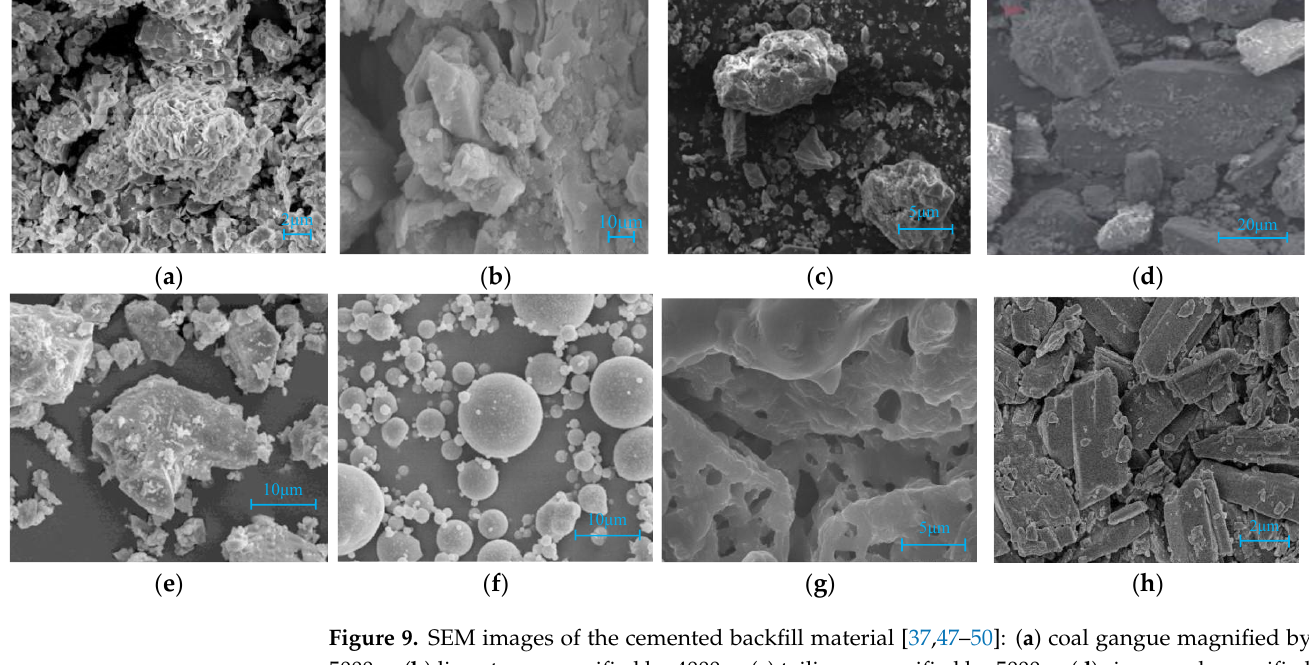
Figure 8. Percentages of the different participants in cemented backfill material. Coal gangue: The most common coarse aggregate in the cement filling material is coal gangue. It is the incombustible rock mass produced during underground coal mining processes, such as the coal cutting procedure at the coal mining face and the blasting procedure at the roadway driving face [28,43]. According to statistics, the quantity of coal gangue comprises approximately 30% of the whole coal production in China, with more than 60% coming from the coal preparation procedure [44,45]. The original coal gangue is always large in size and of poor grading, and it should be cracked to an appropriate lumpiness to facilitate the following transportation and activation processes [46]. An SEM image of coal gangue is provided in Figure 9a.